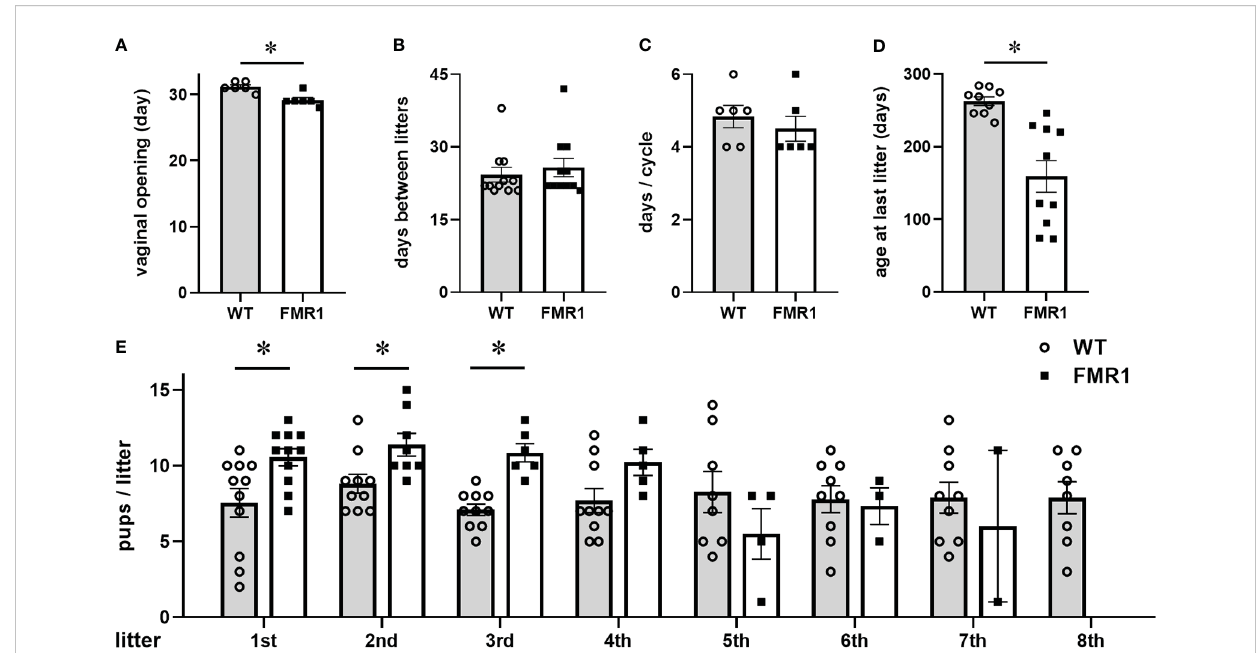
FIGURE 1 Fmr1 knockout (KO) females stop reproducing early. (A) Fmr1 KO females (FMR1, white bars represent group mean +/- standard error, and each black square represents one animal) experience early vaginal opening, an external sign of puberty, at postnatal day (p) 29, compared to wild type controls at p31 (WT, gray bars represent mean +/- standard error, open circles represent each animal); (B) Fmr1 KO females have litters at the same rate as WT controls; (C) No difference in the length of the estrous cycle; (D) Determined by the age at the last litter, Fmr1 KO females stop reproducing early at p163, compared to WT controls at p263; Each point represents one animal, and bars represent group means +/- standard error. Statistical signi fi cance (*, p < 0.05) was determined with t-test followed by Tukey ’ s post hoc test. (E) Fmr1 KO females have more pups per litter in the fi rst three litters. Each circle represents one litter produced by WT females, while each square represents one litter produced by Fmr1 KO females, with number of pups in 1 st – 8 th litter indicated. The number of Fmr1 KO females that continue to produce litters, indicated by squares, decreases gradually. Bars represent group means +/- standard error, * indicates statistically signi fi cant difference between WT and